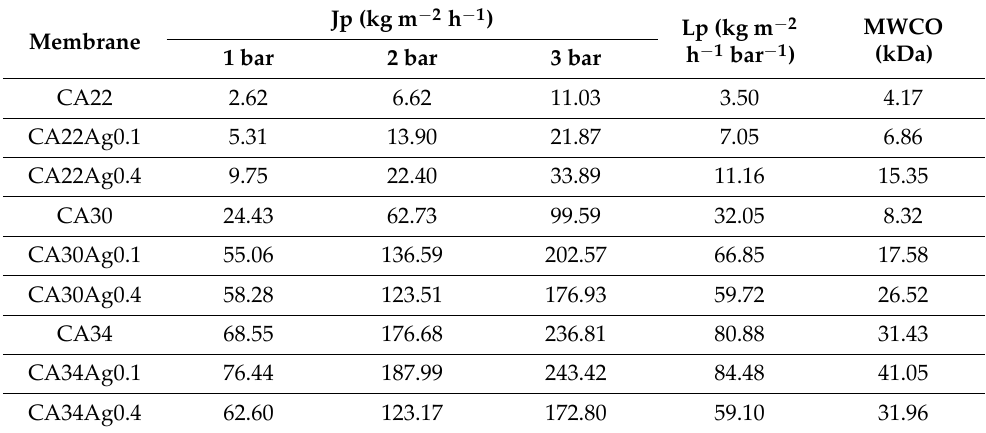
Table 2. CA and CA/Ag pure water fluxes (Jp), hydraulic permeabilities (Lp), and MWCO (mem‑ − 4 brane surface area: 13.2 × 10 m 2